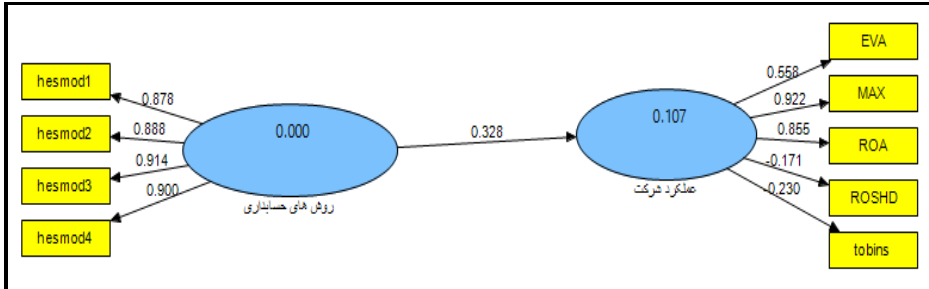
Figure 11. The model path coefficient